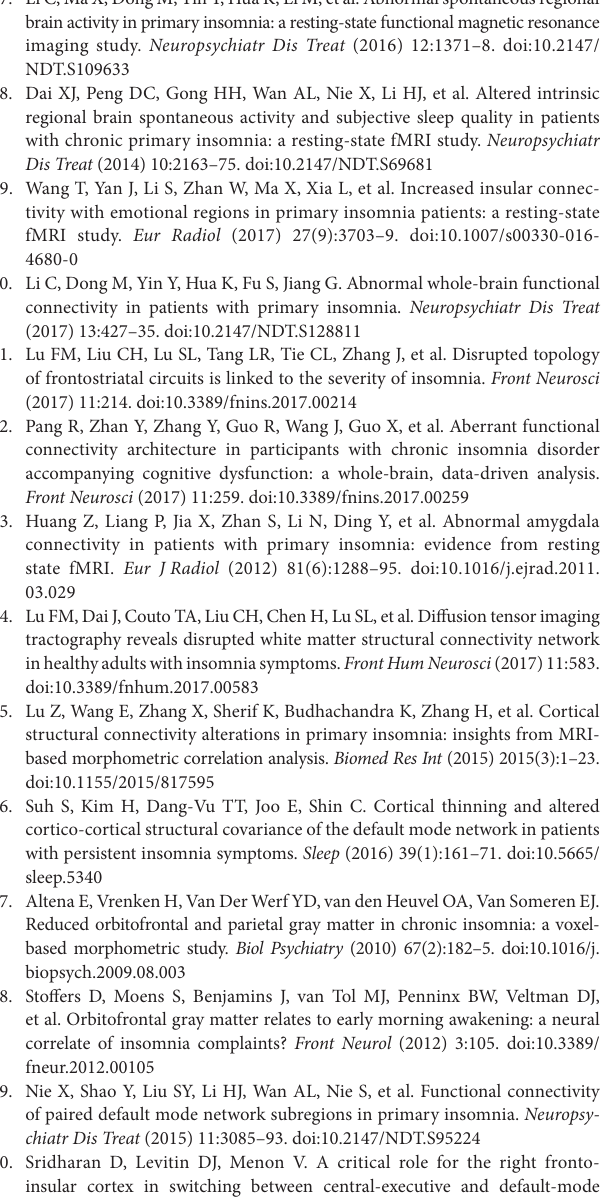
FigUre s2 | The bar graphs demonstrating the mean effective connectivity values in the regions of interest defined as 6-mm-diameter spheres centered on voxels that exhibited the largest absolute t value in each of the significant clusters in the t map. Error bars indicate SD. Abbreviations: Bi_precuneus, bilateral precuneus; L_postcentral gyrus, left postcentral gyrus (extending to left precuneus). FigUre s3 | The bar graphs demonstrating the mean effective connectivity values in the regions of interest defined as 6-mm-diameter spheres centered on voxels that exhibited the largest absolute t value in each of the significant clusters in the t map. Error bars indicate SD. Abbreviations: R_OFC, right orbitofrontal cortex; L_OFC, left orbitofrontal cortex. FigUre s4 | The effective connectivity from ventral right anterior insula to the whole brain. FigUre s5 | The effective connectivity from dorsal right anterior insula to the whole brain.